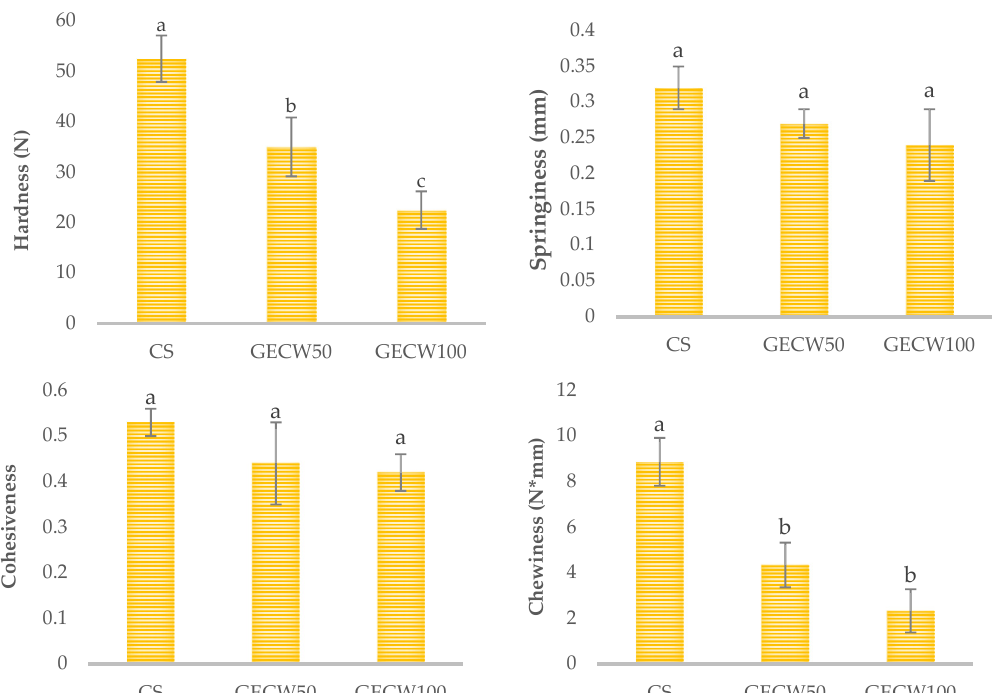
Figure 2. Textural profile analysis of cooked beef burger elaborated with cocoa bean shell flour and walnut oil emulsion gel as partial and total pork backfat replacers. CS: control sample elaborated with the traditional formula; GECW50: sample with 50% gelled emulsion elaborated with cocoa bean shell flour and walnut oil as fat replacer; GECW100: sample with 100% gelled emulsion elaborated with cocoa bean shell flour and walnut oil as fat replacer. Bars with different letters are significantly different ( p < 0.05).